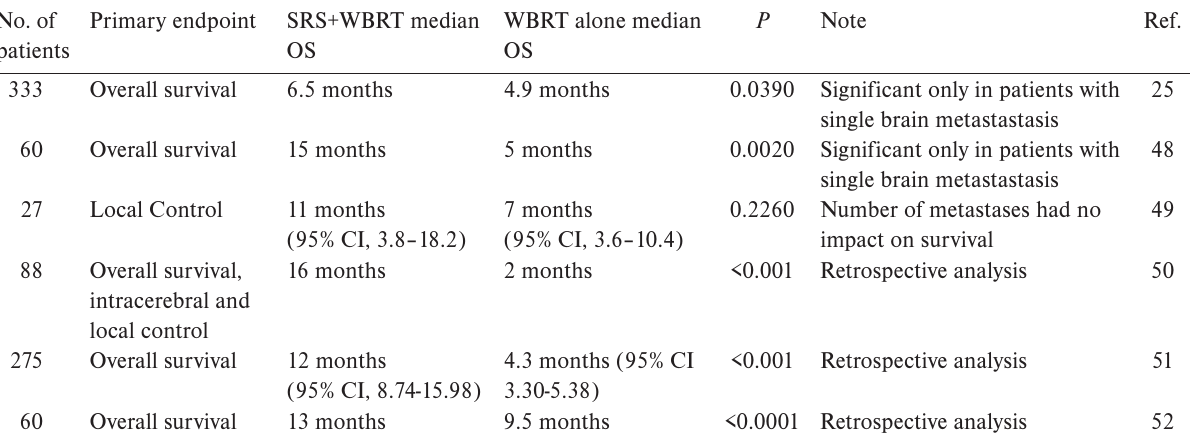
Table 1. Overview of studies comparing SRS plus WBRT versus WBRT